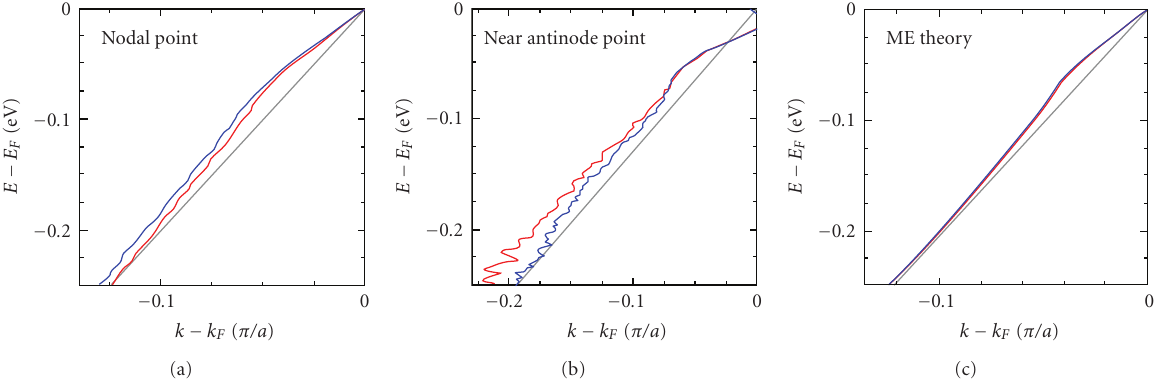
Figure 14: (a-b) Comparison of ARPES MDC dispersions for these two locations with the di ff erent isotopes. (c) Migdal-Eliashberg (ME) simulation for change in dispersion with isotope again under-predicting the magnitude and location of the expected band structure change.